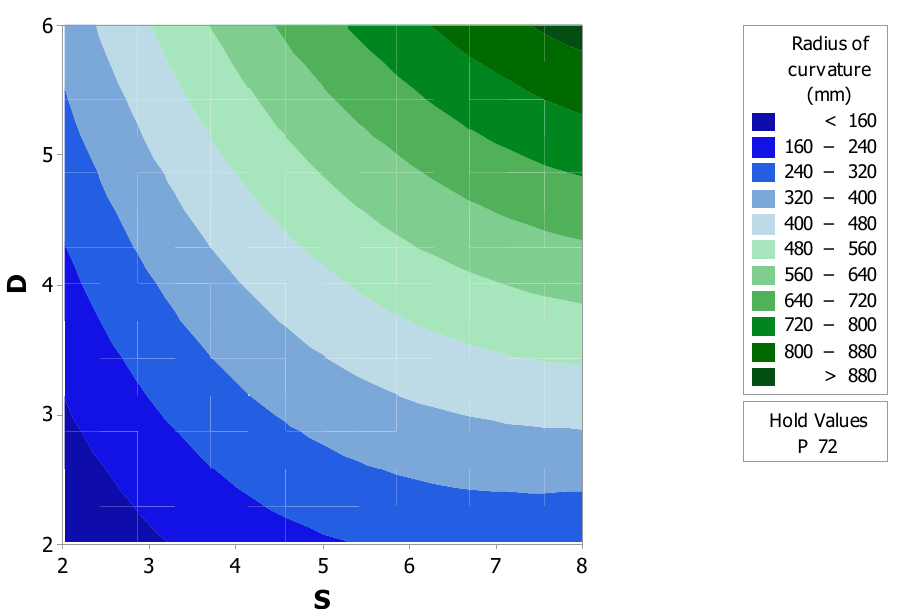
Figure 5. The interaction between scanning speed and distance between irradiation lines on the radius of curvature.